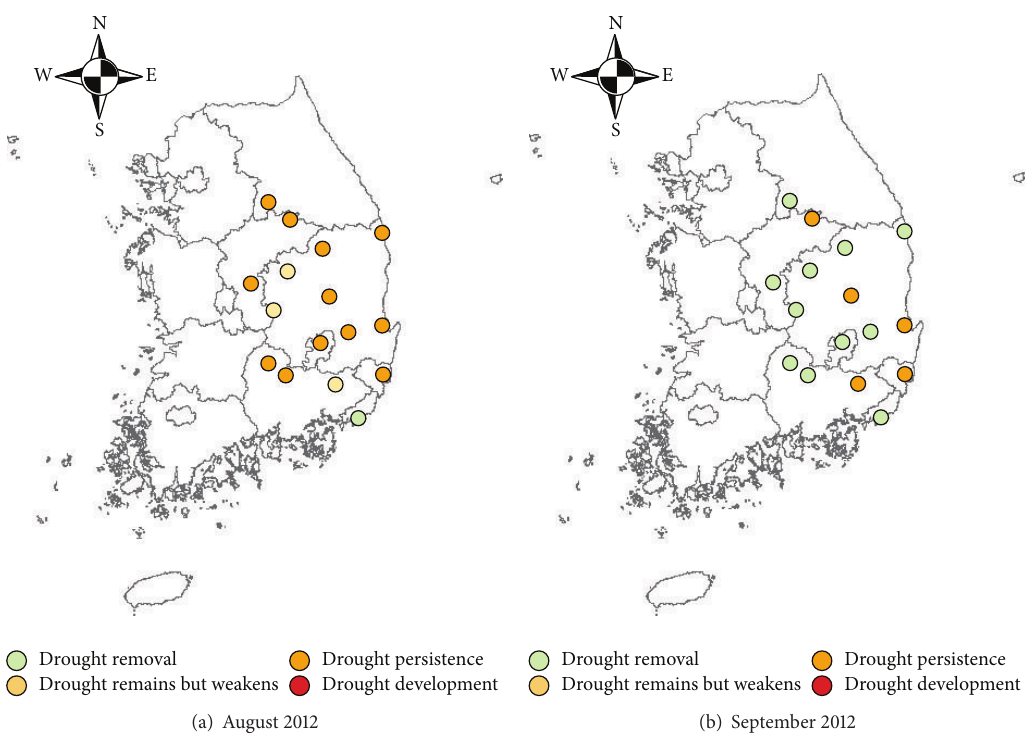
Figure 8: The map of drought outlook in study